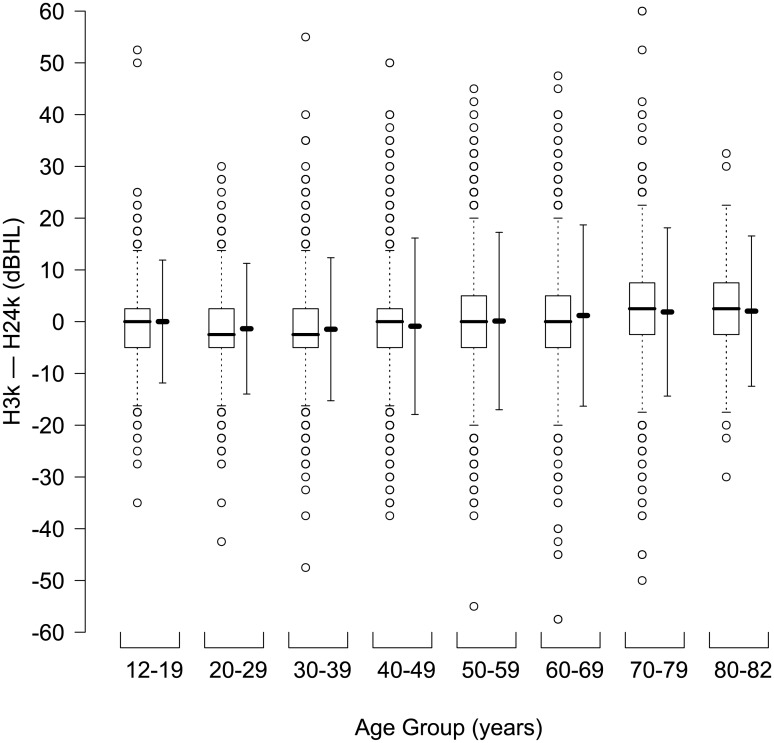
Box-and-whisker plot (left) combined with mean difference and limit of agreement (LOA, right) for the decibel difference between the threshold at 3 kHz (H3k) and the average of thresholds at 2 kHz and 4 kHz (H24k) according to eight age groups (weighted N = 39,357,497 × 2 ears, age: 12–82 year-old).The box height is the interquartile range (IQR = Q3 –Q1) of the decibel difference for each age. The thick horizontal line in the box is the median (Q2). Outliers are marked as empty circles below the vertical dotted line from the box (Q1–1.5 IQR) and above the dotted line (Q3 + 1.5 IQR). This boxplot shows that the median and the interquartile range of difference between H3k and H24k are distributed around zero, irrespective of age group. Therefore, it can be interpreted that H3k and H24k had very similar mean values in all cases. In addition, the absolute limit of agreement in all age group was very large irrespective of age. dBHL: decibel hearing level; H2k: threshold at 2 kHz; H3k: threshold at 3 kHz; H4k: threshold at 4 kHz; IQR: interquartile range; Q1: first quartile (25 percentile); Q2: second quartile (median, 50 percentile); Q3: third quartile (75 percentile).